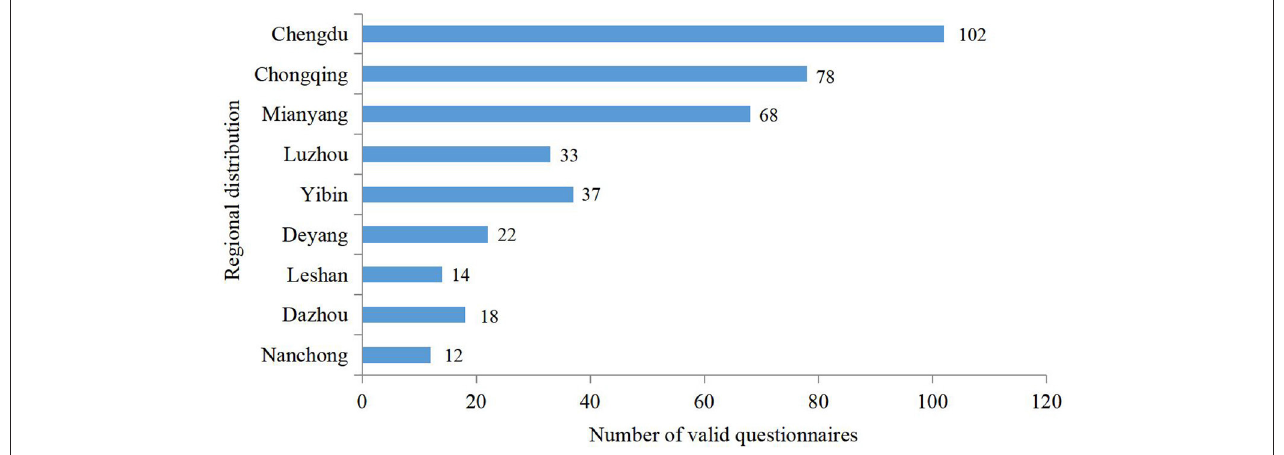
FIGURE 2 | Regional distribution of valid